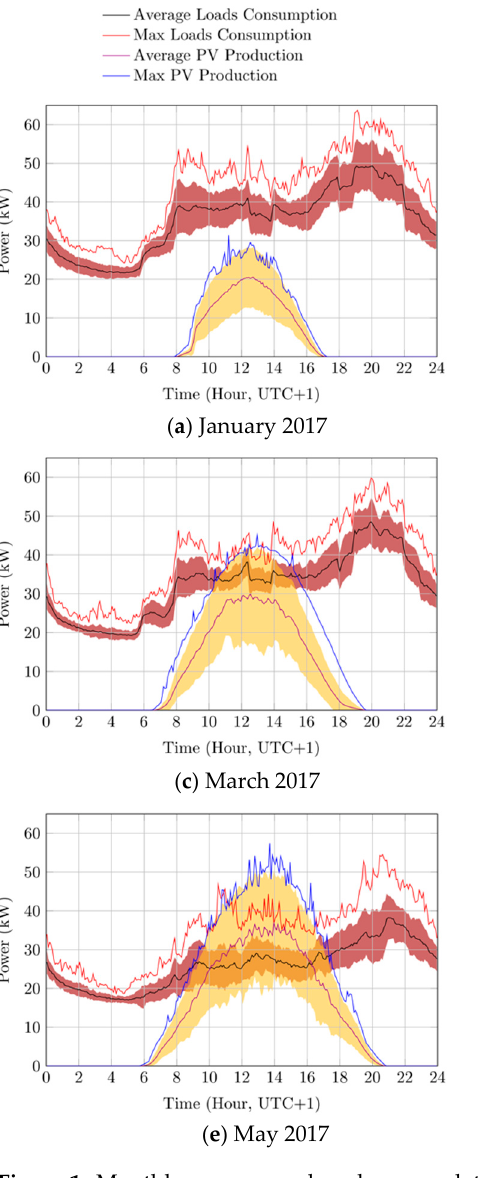
Figure 1. Monthly average and peak power data of photovoltaic (PV) production and user’s loads recorded from January to June 2017, as depicted from sub-figure ( a ) to sub-figure ( f ), respectively. The yellow and red area represent the standard deviation of PV and loads data, respectively. UTC: Universal Time Coordinated.